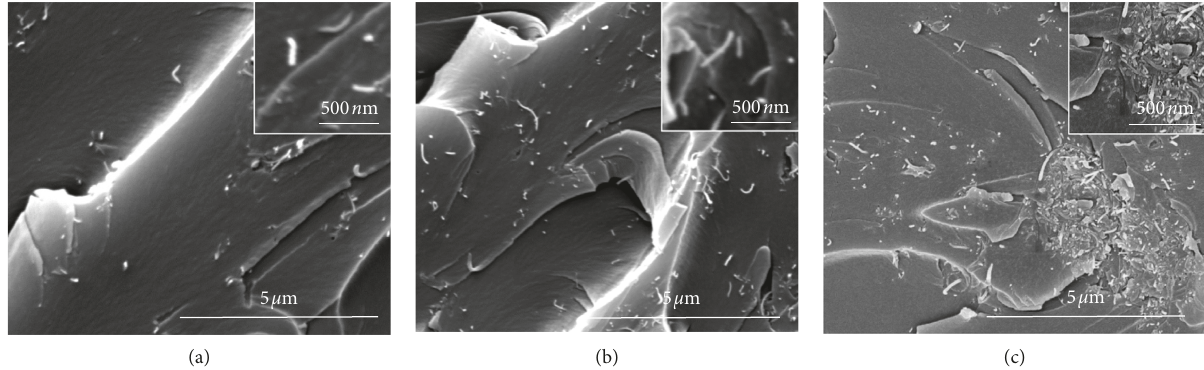
Figure 1: Fracture surface of CNTs/EP composites at different contents of CNTs: (a) 0.2 wt.%, (b) 1.0wt.%, and (c)